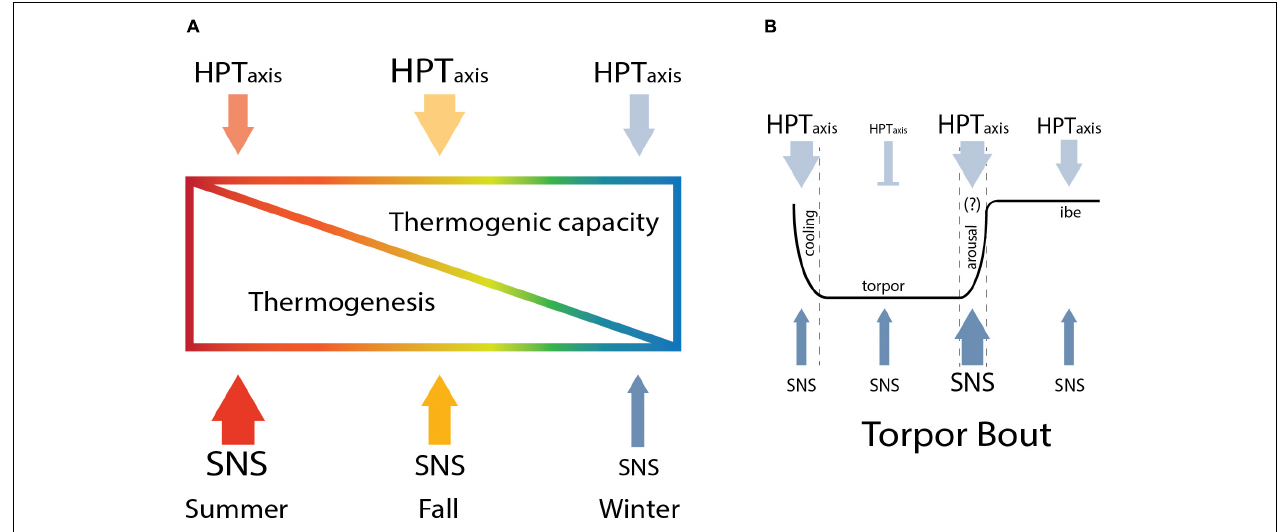
FIGURE 5 | Seasonal modulation of thermoregulation in hibernation. The HPT axis and SNS change across season to increase thermogenic capacity in winter and gradually reduce thermogenesis from summer to winter (A) until arousal, when the higher thermogenic capacity is critical to sustain thermogenesis needed to rewarm from torpor (B)